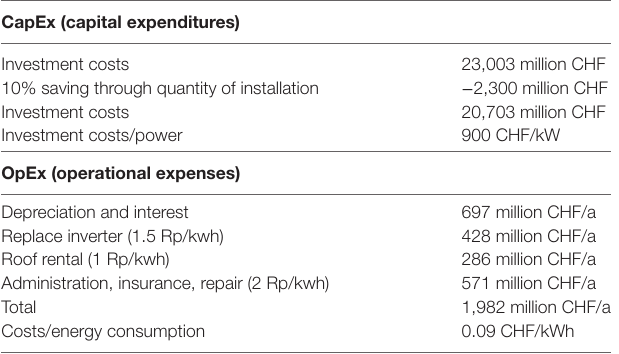
TaBle 6 | Breakdown of the costs for the photovoltaic plant for a total installed plant power of 23 GW. capex (capital expenditures)